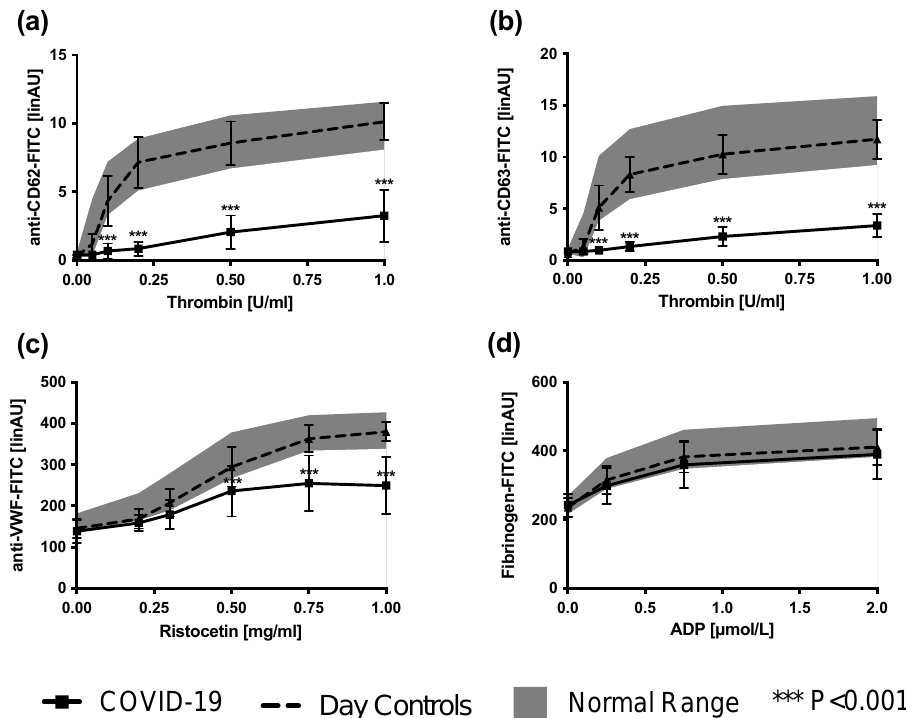
Figure 2. Surface expression of CD62 ( a ) and CD63 ( b ) in diluted platelet-rich plasma obtained from COVID-19 patients ( n = 13) in comparison to day controls after stimulation with increasing concen-